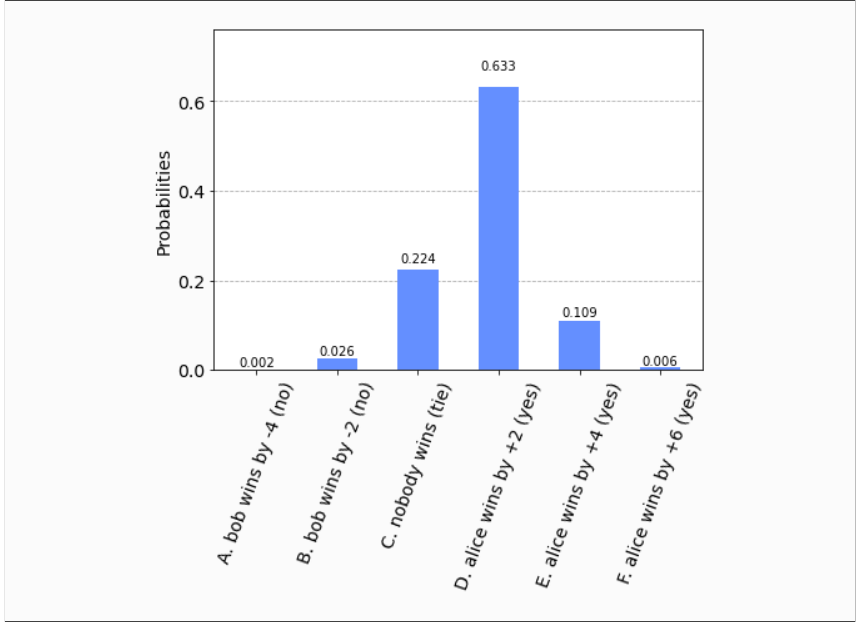
Figure 6. The possible outcomes and their probabilities when r A = r B = 0.3.